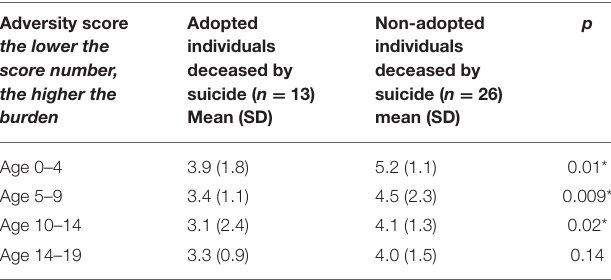
TABLE 3 | Comparison of the burden of adversity score depending on age between adopted and non-adopted individuals deceased by suicide ( n = 39). Adversity score the lower the score number, the higher